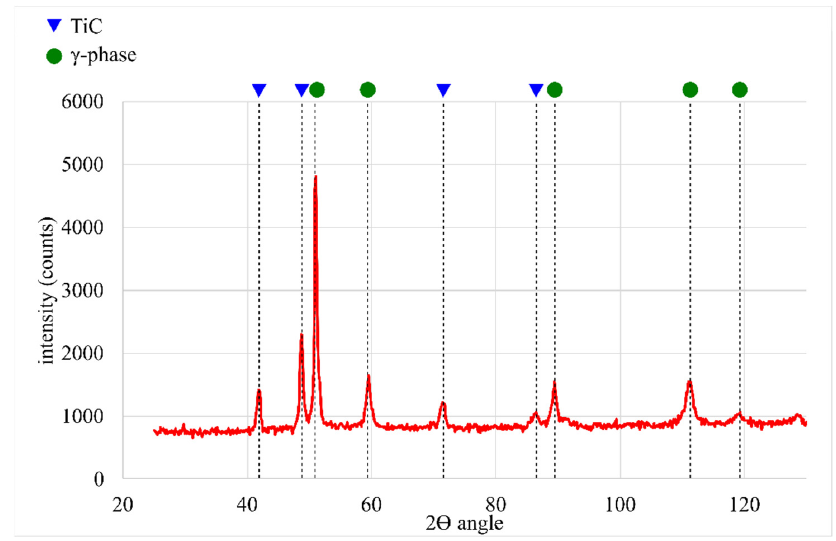
Figure 6. XRD results of the representative composite Inconel 625/TiC coating.